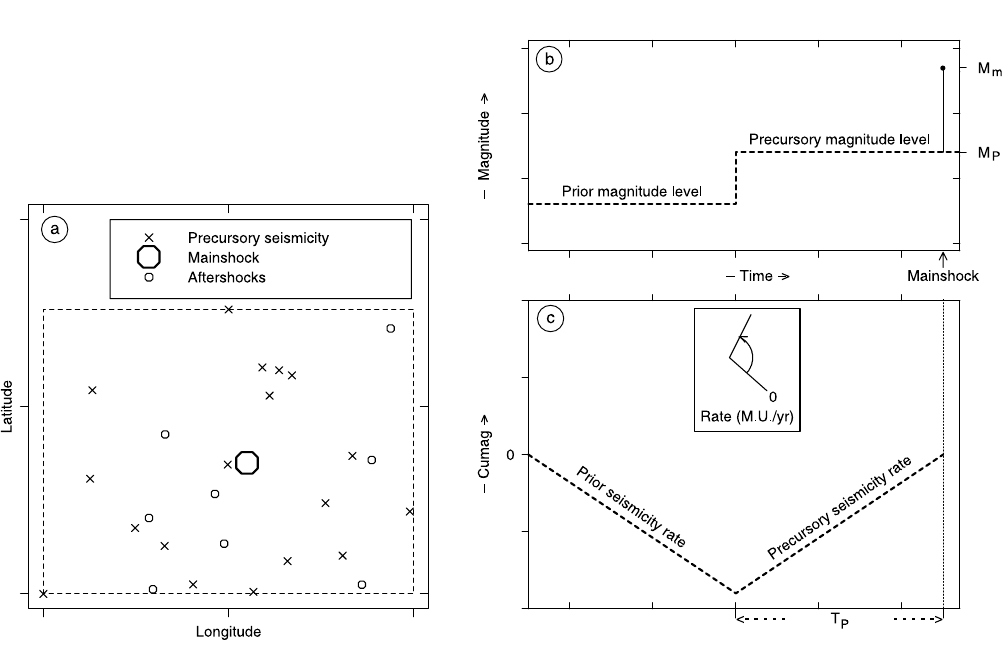
Fig. 1a-c. (cid:115) -phenomenon: schematic. a) Typical epicentral area of precursory seismicity, mainshock and after- shocks. b) Prior magnitude level and jump to precursory level M the average of the three largest magnitudes in the relevant period of time. M and precursory seismicity rates, showing sudden change at start of precursor time T from the data by means of the cumag (see eqs. (2.1) and (2.2)); it is averaged over the relevant period of time. A protractor is included to indicate the rate corresponding to any given slope; rate is given in units of magnitude above base-level, per year